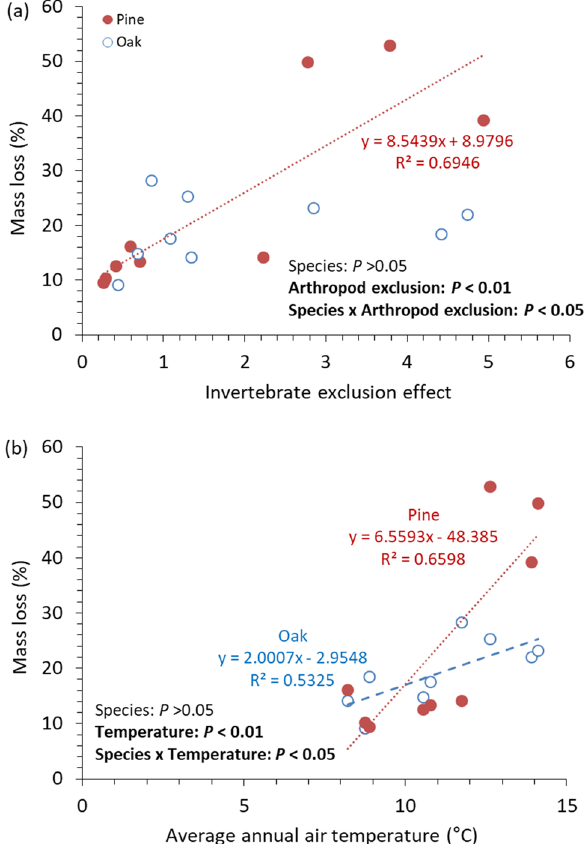
Figure 5. Relationships of mass loss of deadwood samples after 24 months to invertebrate exclusion effect ( a ) and average annual air temperature ( b ). Only significant regression lines are presented on each panel (n = 9, P < 0.05). Dots in each panel represent the average value from three plots within each study site. The higher invertebrate exclusion effect indicates the larger decrease in the mass loss rate of deadwood samples by invertebrate